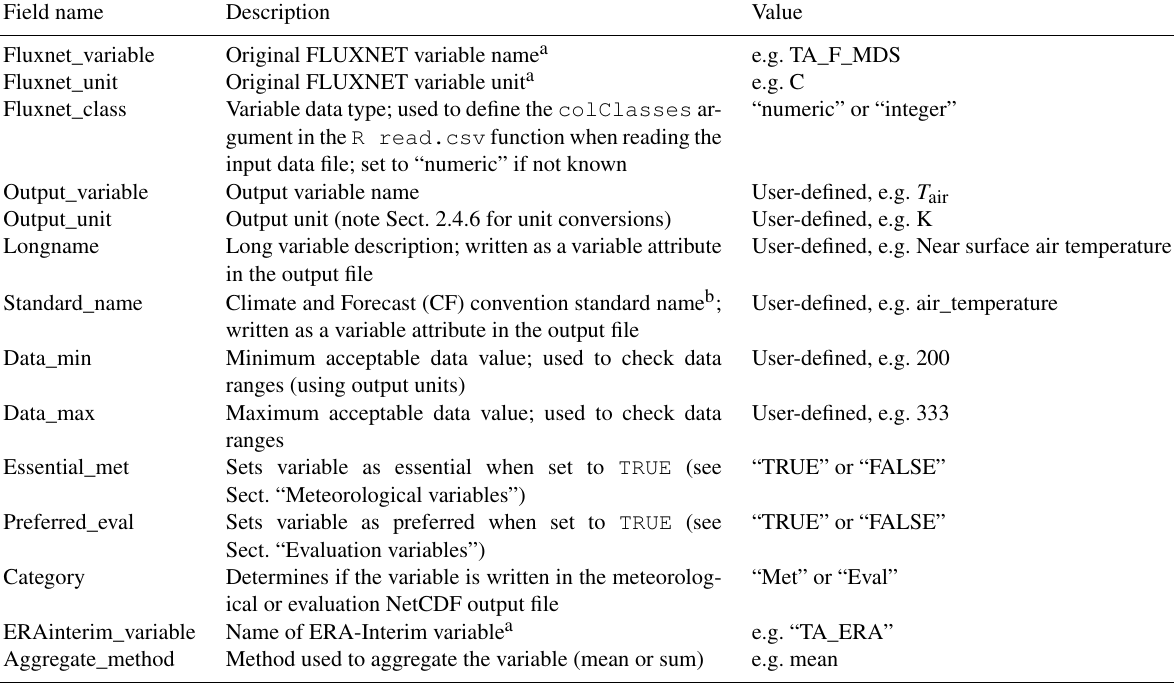
Table 3. Attributes required for each output variable (stored separately for FLUXNET2015 and La Thuile data releases in data/Output_variables_*.R